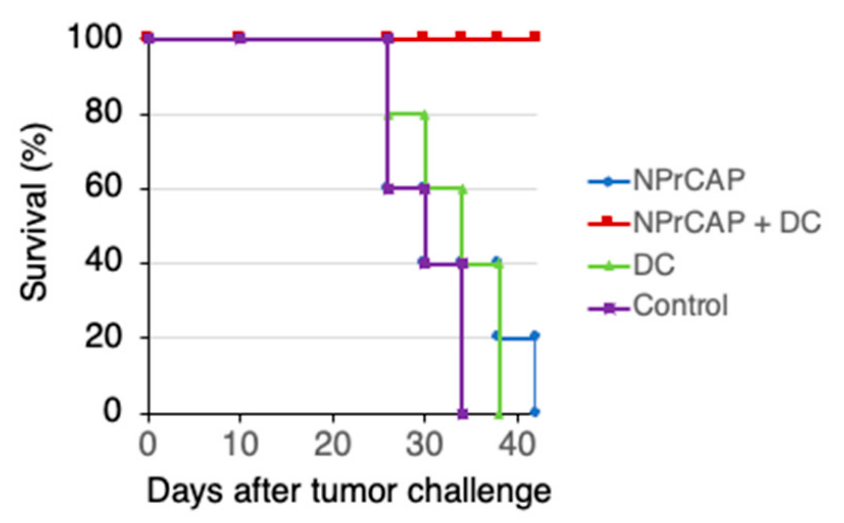
Figure 4. Combination therapy using N -Pr-4- S -CAP and BMDCs resulted in prolongation of the survival periods of B16F1-bearing mice. Kaplan–Meier survival curves after tumor transplantation showed significant prolongation of survival in the combination therapy ( N -Pr-4- S -CAP and BMDCs) group compared to the control group ( p < 0.05).